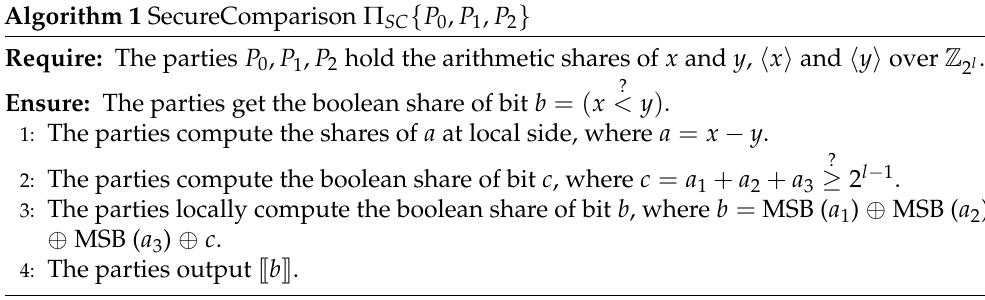
Algorithm 1 SecureComparison Π SC { P 0 , P 1 , P 2